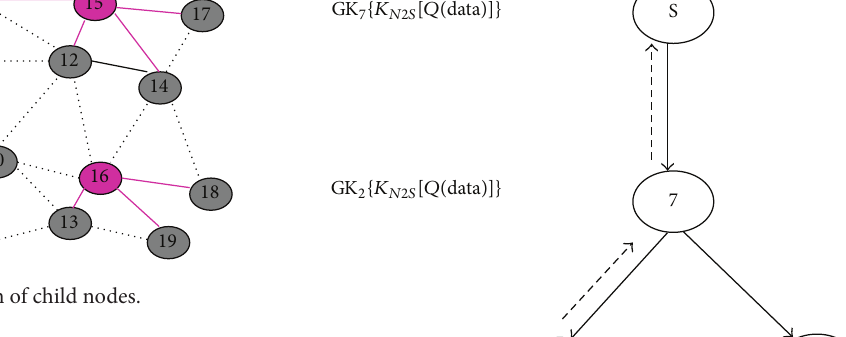
Figure 4: Secure data